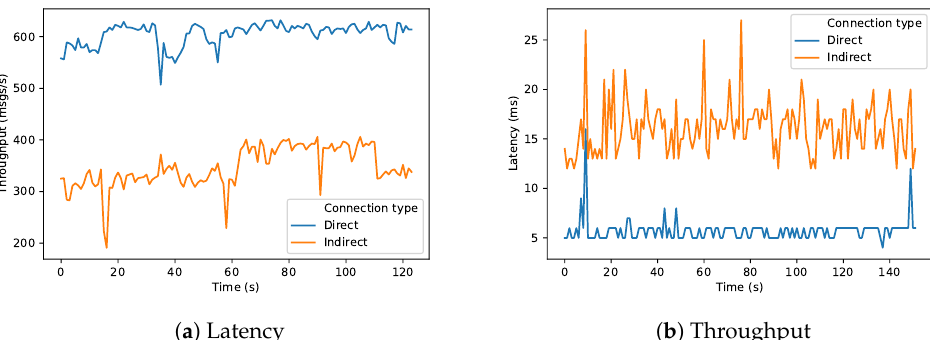
Figure 9. Performance measurements of analysis application in direct vs. indirect